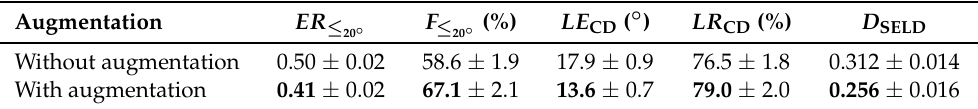
Table 6. Performance of our DCMA-SELD models trained with and without data augmentation for model training on the TNSSE 2021 development dataset. All data represent mean values and associated 95% confidence intervals. The highest performance in each metric is indicated in